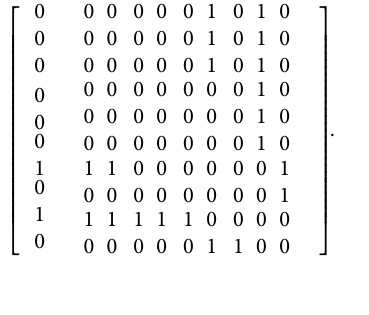
TABLE 5 Manufacturing company resource key score. enterprise